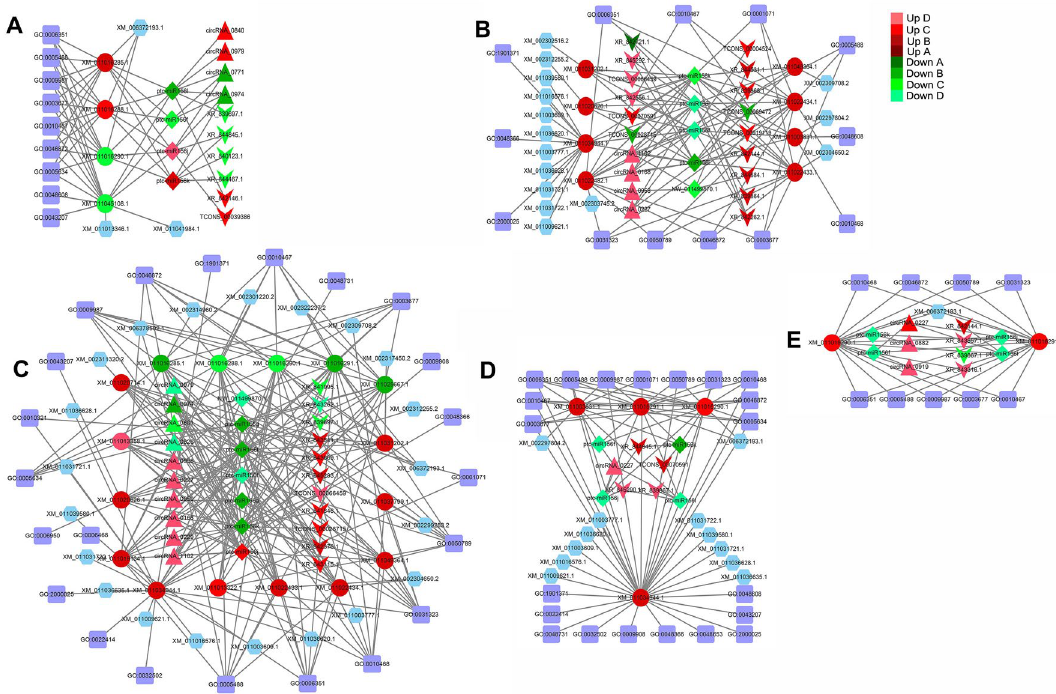
Figure 7. Regulatory networks and functional predictions of ncRNAs and mRNAs (SPL TFs) in the 5 sample pairs of P. euphratica. ( A – E ) show La/Li, Ov/Li, Bo/Li, Bo/La, and Bo/Ov sample pairs, respectively. The purple squares represent GO IDs; the diamonds, triangles, Vs, ellipses, and hexagons represent miRNAs, circRNAs, lncRNAs, SPL TFs, and target genes, respectively. As indicated in the upper right corner, red indicates up-regulated expression, among them twofold ≥ Up A > onefold, fivefold ≥ Up B > twofold, tenfold ≥ Up C > fivefold, Up D > tenfold; green indicates down-regulated expression, among them twofold ≥ Down A > onefold, fivefold ≥ Down B > twofold, tenfold ≥ Down C > fivefold, Down D > tenfold. This figure was generated by Cytoscape 3.8.2 (https:// cytos cape. org/).